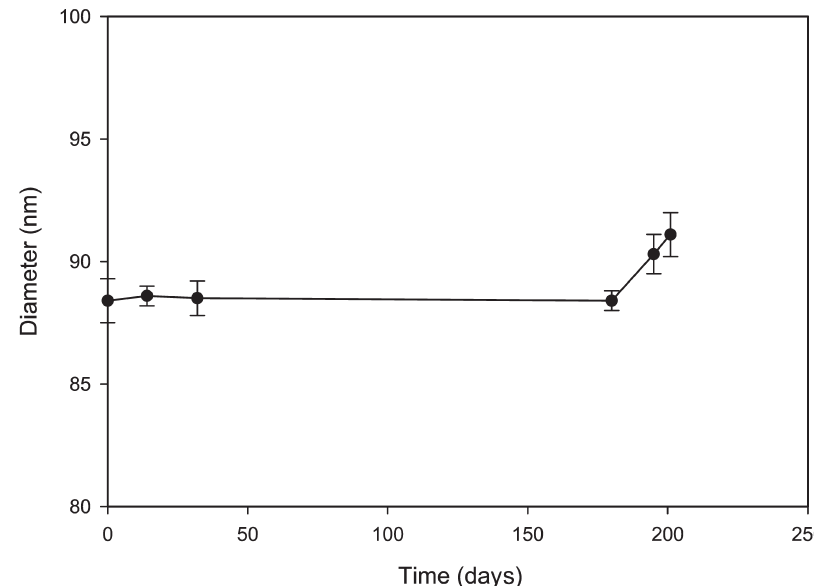
Figure 2. Vesicle size of PLFE small unilamellar vesicles as a function of storage time at room temperature in 50 mM KCl. The PLFE concentration was 0.05